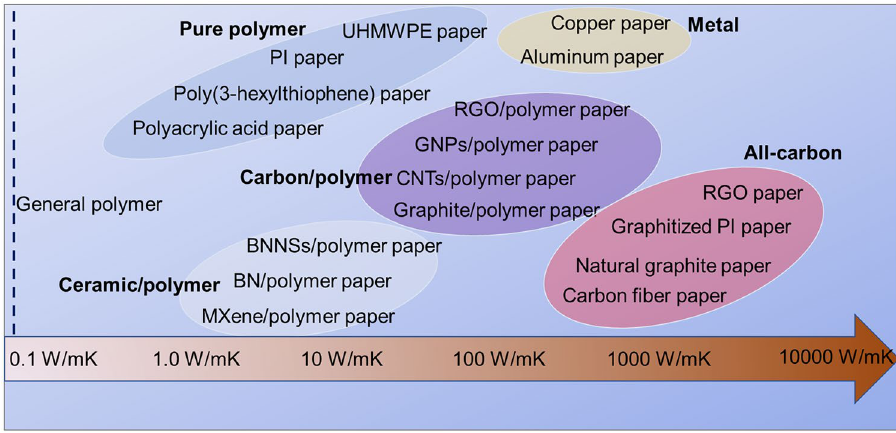
Fig. 2 The summary of flexible thermally conductive films with different in‑plane